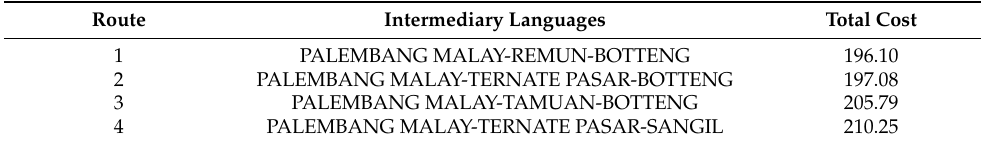
Table 4. Total Cost for the path from Bali to Buginese using Yen’s K Algorithm with K = 4.